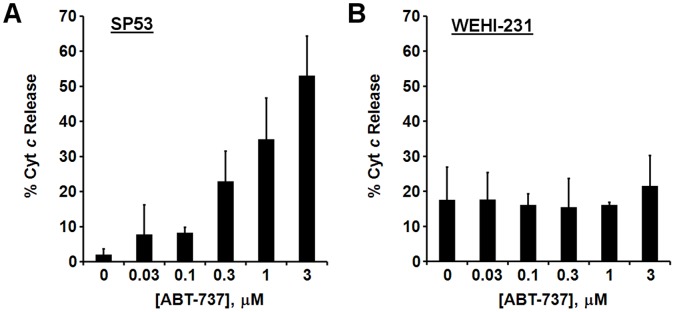
Dose-dependent cytochrome c redistribution in SP53 cells but not WEHI-231 cells treated with ABT-737.Saponin (10 µg/ml) was injected to liberate the contents of the cytoplasm into the assay medium after a 30 min incubation of intact cells with vehicle or ABT-737 (as indicated). Assays were conducted using the XF24 and the saponin injection corresponded to the time of oligomycin injection in Fig. 7. Cyt c was quantified by ELISA in the medium and cell lysate. Results are expressed as % cyt c released into the medium compared to the total cyt c that was quantified (mean ± SD, n = 3). (A) SP53 cells. (B) WEHI-231 cells.